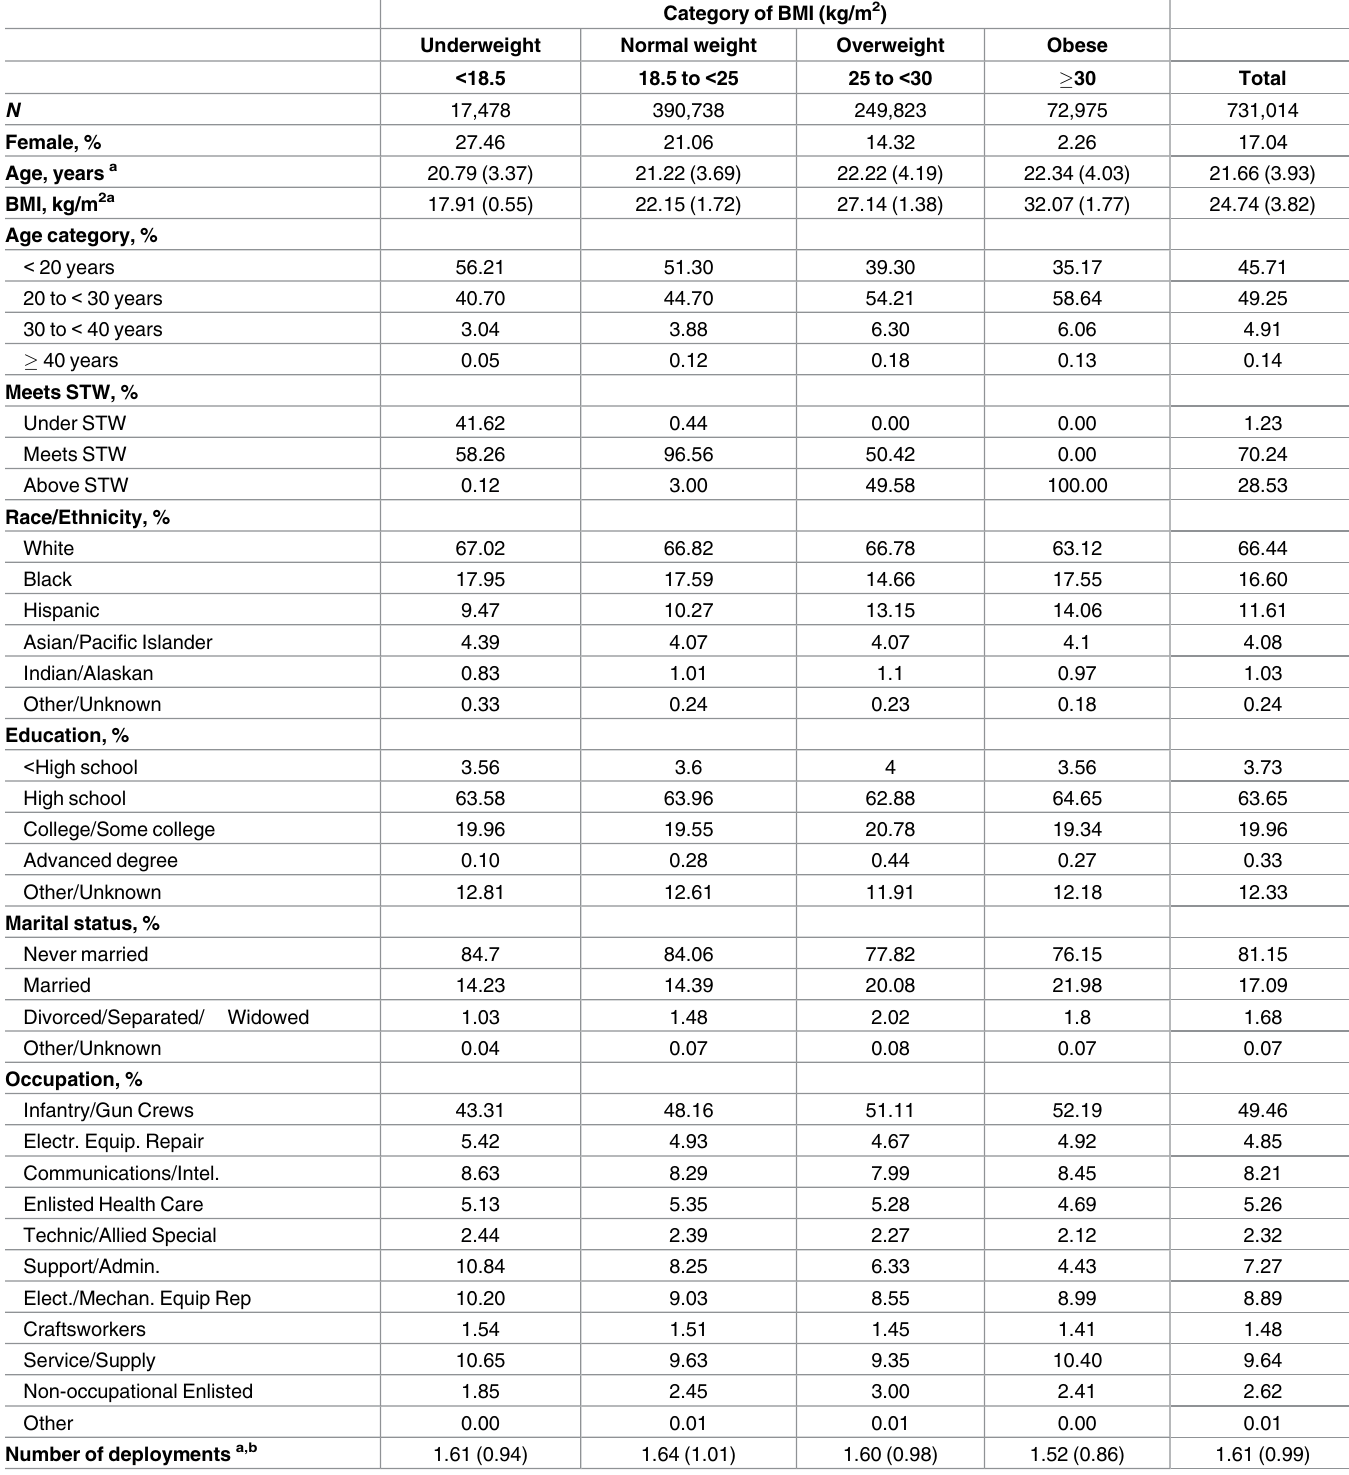
Table 1. Baseline characteristics by BMI category of 731,014men and women accessinginto the US Army, 2001–2011.